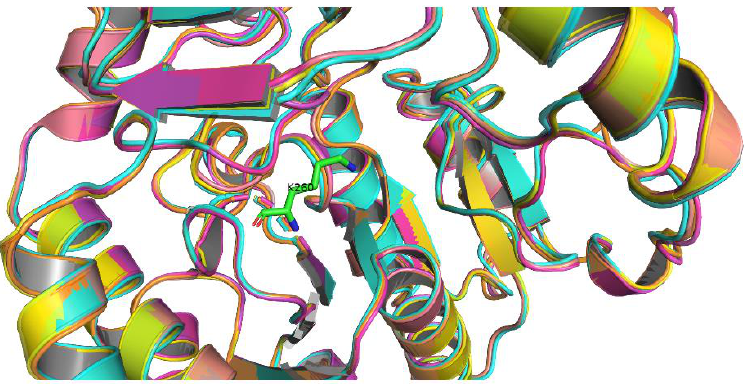
Figure 4. Superimposition of the crystal structure from FumIS (salmon), FumIB (yellow), FumTSTA (orange), FumPHTA (cyans), and FumUPTA (magenta) transaminases; Green stick structure represent the catalytically active Lys residue of FumTSTA.